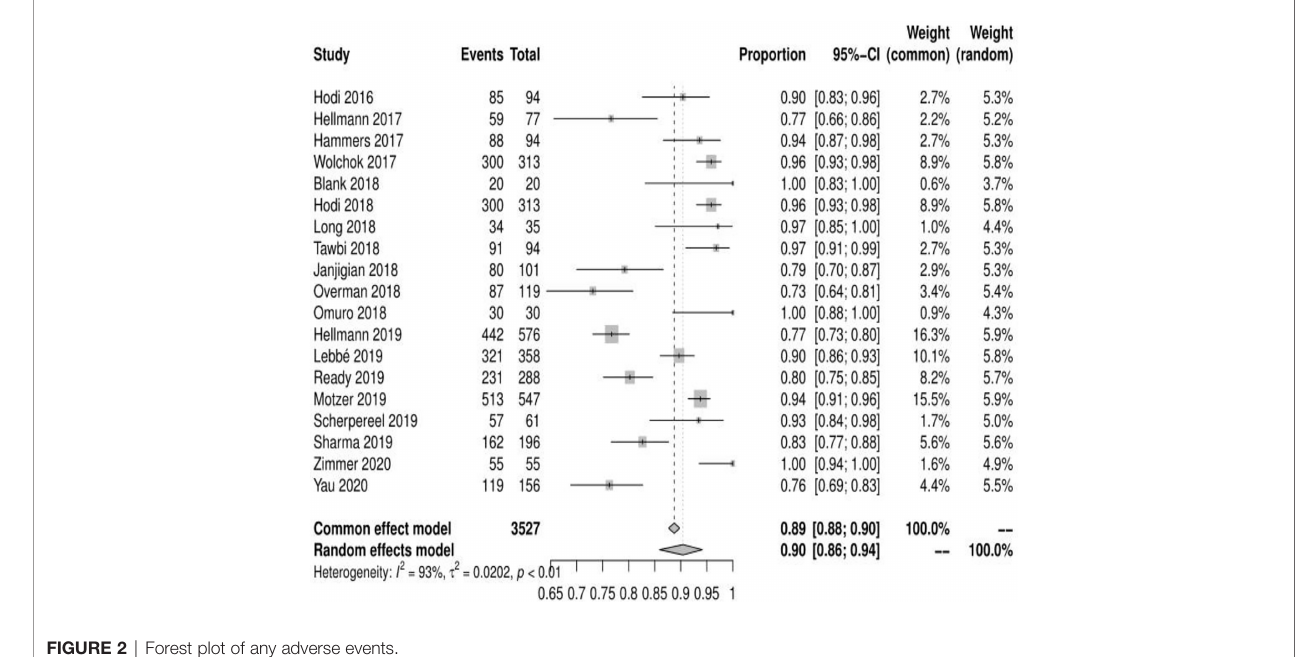
FIGURE 2 | Forest plot of any adverse events.